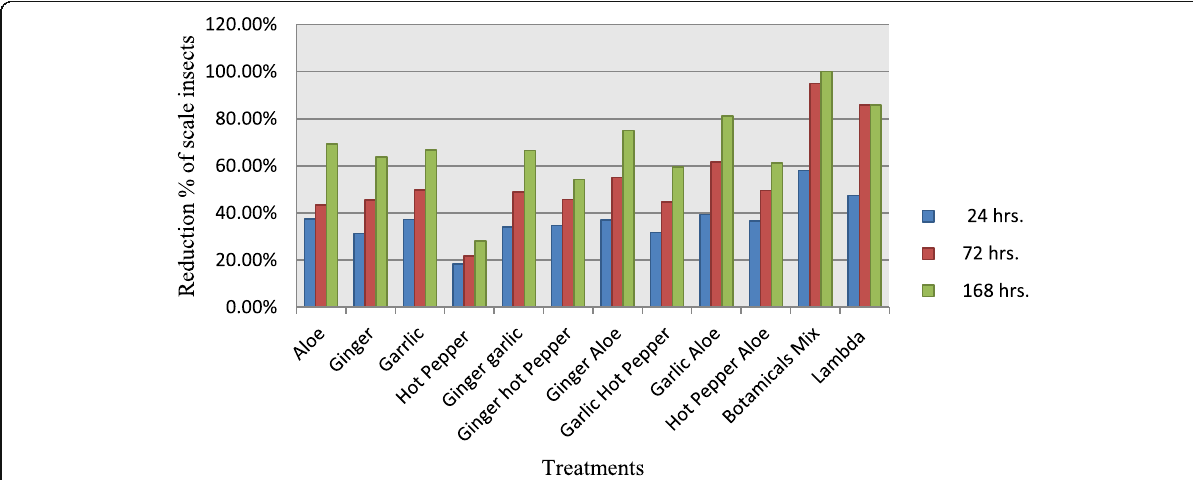
Fig. 2 Reduction percentage of mango scale insect, Aulacaspis tubercularis , after different treatments by plant extracts in season of